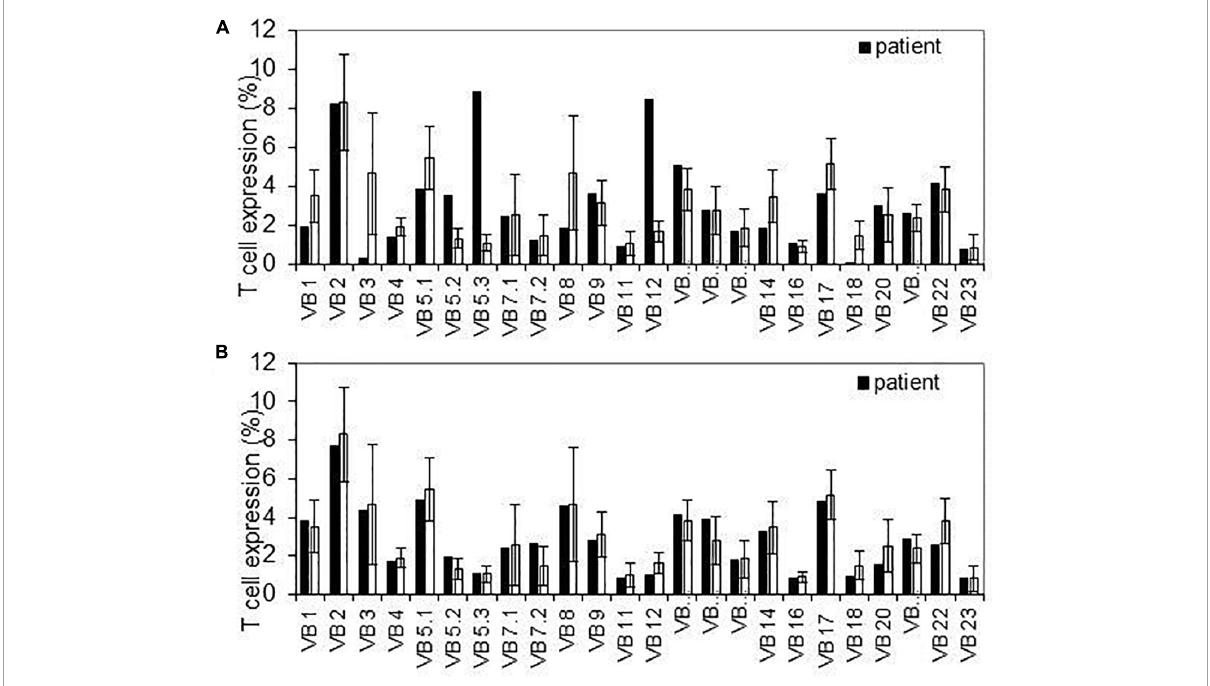
FIGURE2 T-cell receptor repertoire detected variable segment usage for T cell receptor β . Flow cytometer analysis of surface membrane expression of 24 T cell receptor β variable segments in infants with slightly abnormal pattern (upper panel- A ) and normal pattern (lower panel- B ) compared to average expression on healthy controls. Error bars indicate SD across